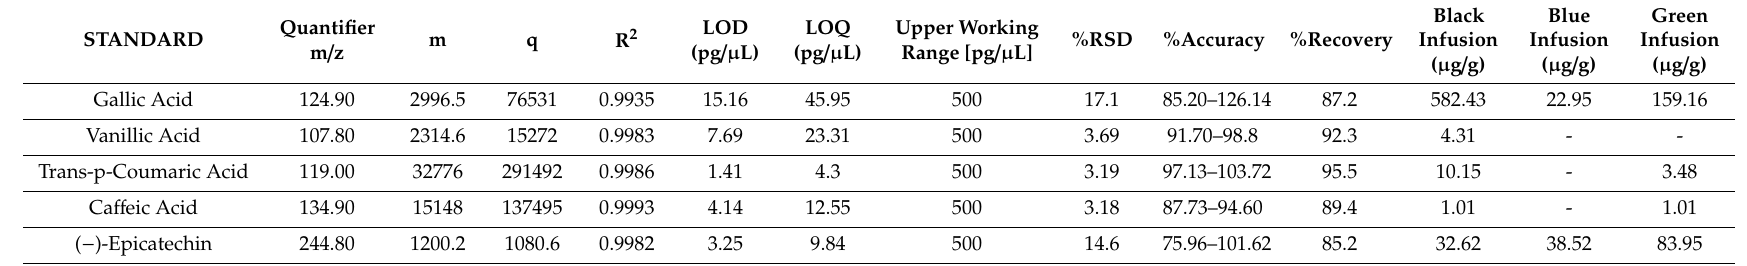
Table 1. Limit of detection (LOD), limit of quantification (LOQ), repeatability (%RSD), accuracy (%), matrix e ff ect (%Recovery) calculated for six standard molecules, upper limit of working range (pg / µ L), y-intercept, angular coe ffi cient for the calculated calibration curves obtained for each standard compound are